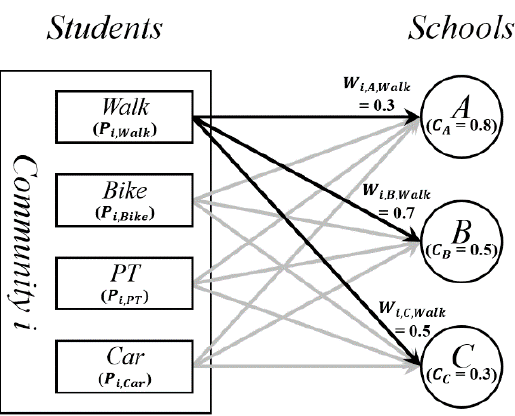
Figure 2. The probabilities of students’ choice of different schools in the communities under multiple travel modes.